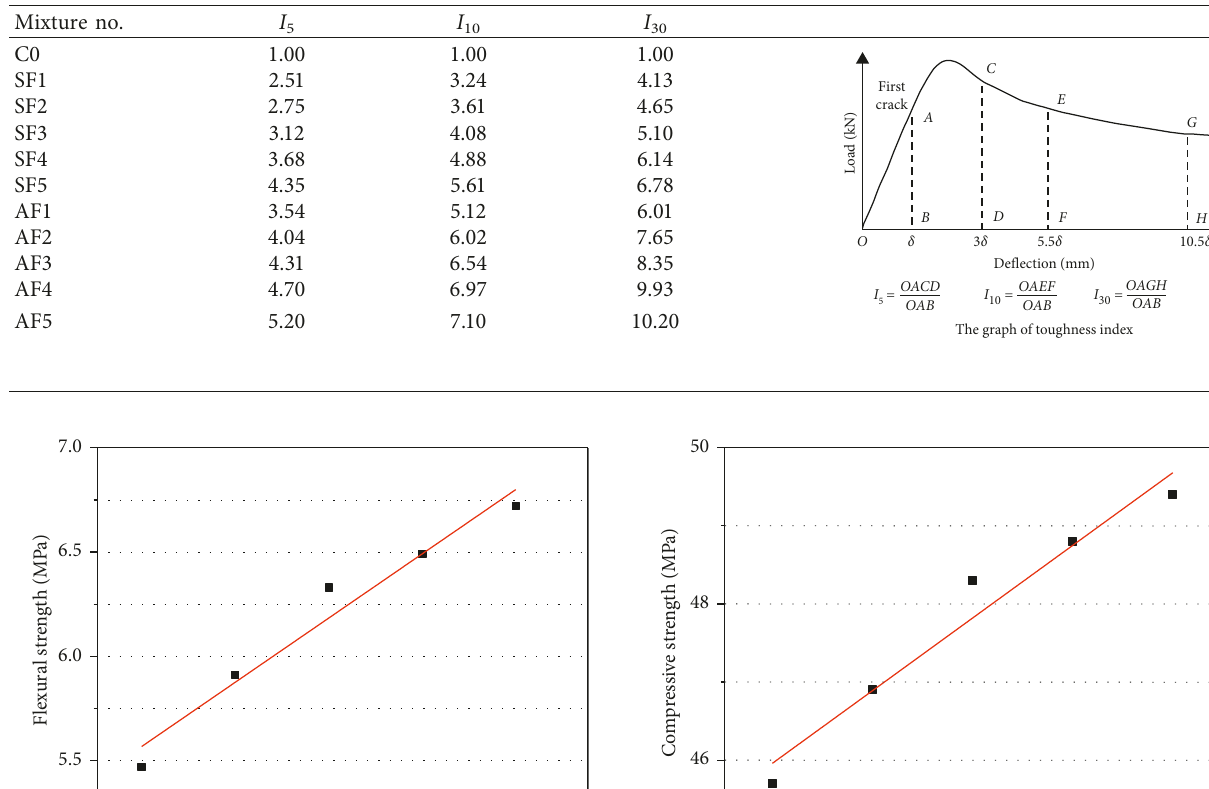
Table 8: Toughness index of FRC.